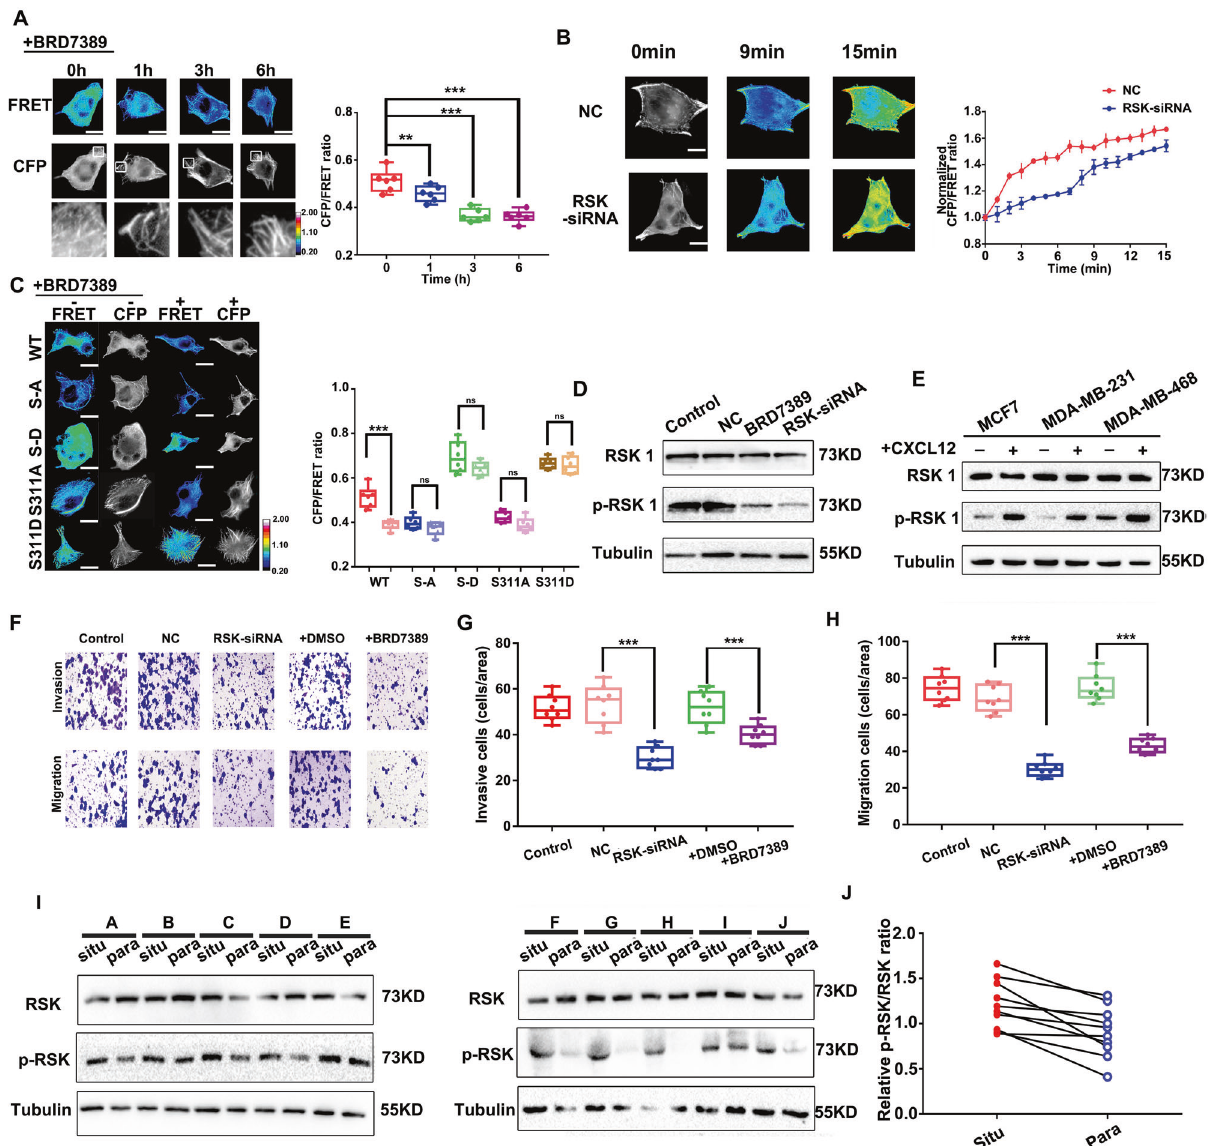
Fig. 6 RSK promotes Clip170 tension and breast cancer aggressiveness. A Left panel: Representative images of FRET analysis of cells treated with the RSK inhibitor (BRD7389) for 0, 1, 3, and 6 h. Calibration bar, 0.2 – 2.0; scale bar, 10 μ m. Right panel: Mean CFP/FRET ratios for the whole cell. (mean ± SEM, n ≥ 6 cells in each group, * *P < 0.01, *** P < 0.001 compared with 0h-treatment group). B Left panel: 15-min time-lapse images of FRET analysis in MDA-MB-468 cells transfected with the Clip170-cpstFRET probe alone or combined with RSK siRNA. Calibration bar, 0.2 – 2.0; scale bar, 10 μ m. Right panel: Normalized CFP/FRET signals for the whole cell corresponding to Clip170 tension versus time (mean ± SEM, n ≥ 5 cells in each group). C Left panel: Representative images of FRET analysis of MDA-MB-468 cells transfected with the Clip170-cpstFRET, Clip170-S-A-cpstFRET, Clip170-S-D-cpstFRET, Clip170-S311A-cpstFRET, or Clip170-S311D-cpstFRET probes treated with the RSK inhibitor (BRD7389) for 6 h. Calibration bar, 0.2 – 2.0; scale bar, 10 μ m. Right panel: Mean CFP/FRET ratios for the whole cell. (mean ± SEM, n ≥ 6 cells in each group, *** P < 0.001 compared with the cells without BRD7389 treatment). D Western blotting analysis of RSK -siRNA and RSK inhibitor treatment in MDA-MB-468 cells. E Western blotting analysis of RSK and p-RSK levels in MDA-MB-468, MCF7, and MDA-MB-231 after CXCL12 treatment. F Representative images of the migration and invasion of control, NC, RSK -siRNA, DMSO, and RSK inhibitor (BRD7389) treatment groups. G – H Quantitative analysis of the migration ( G ) and invasion ( H ) rates (Mean ± SEM, n = 3 independent experiments and at least three fi elds, ***P < 0.001 compared with NC or DMSO group). I Western blotting analysis of RSK and p-RSK levels in breast cancer tissue (situ) and adjacent normal tissue (para). J Quantitative analysis of the p-RSK/RSK ratio in breast cancer tissue and matched normal tissues ( n = edges, and IQGAP2 knockdown reinforced the difference (Fig. 8C). length of the comets and increased their quantity, and cells Therefore, a Transwell assay was performed, which revealed that overexpressing IQGAP2 exhibited signi fi cantly fewer, but longer, MDA-MB-468 cells transfected with IQGAP2 -siRNA displayed comets. Meanwhile, IQGAP1 knockdown only increased the attenuated aggressiveness and cells in IQGAP2 overexpression Clip170 comet length but did not affect the quantity (Fig. 8A, B). and IQGAP1 knockdown groups showed intensi fi ed invasion and In the directional migration model, IQOGP1 knockdown reversed migration abilities (Supplementary Fig. 5D). These results suggest the Clip170 tension difference between the leading and follow